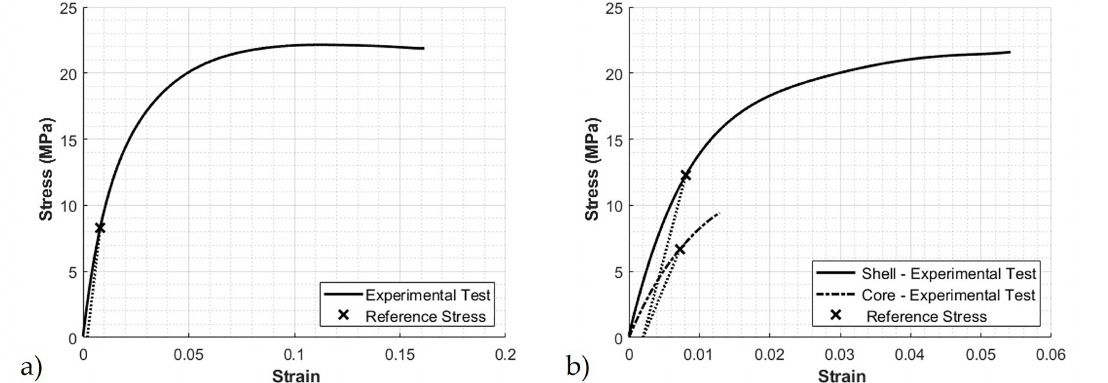
Figure 11. Reference stress at 0.2% reference strain obtained from ( a ) stress-strain curves from HDPE tensile tests ( b ) stress-strain curves for the shell and